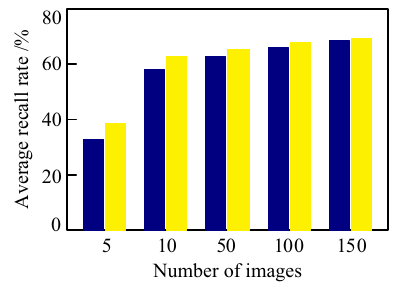
Figure 3: Comparison of average recall rate of words in ML and σ ML bins.